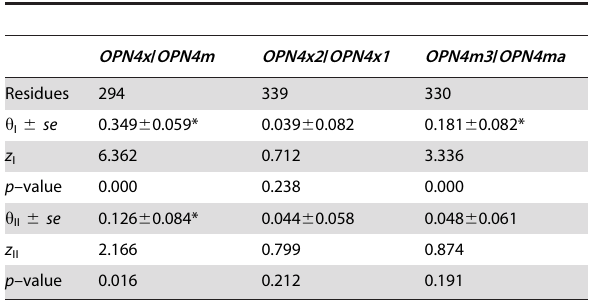
Table 2. Type I and type II divergence between the OPN4 paralogs and the teleost lineage-specific